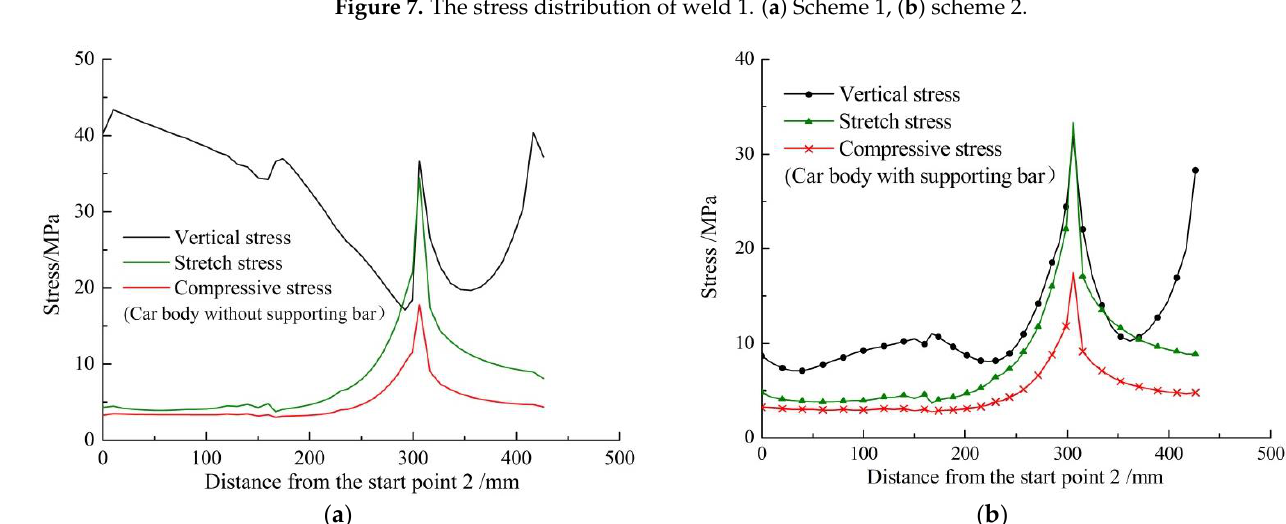
Figure 8. The stress distribution of weld 2. ( a ) Scheme 1, ( b ) scheme 2.